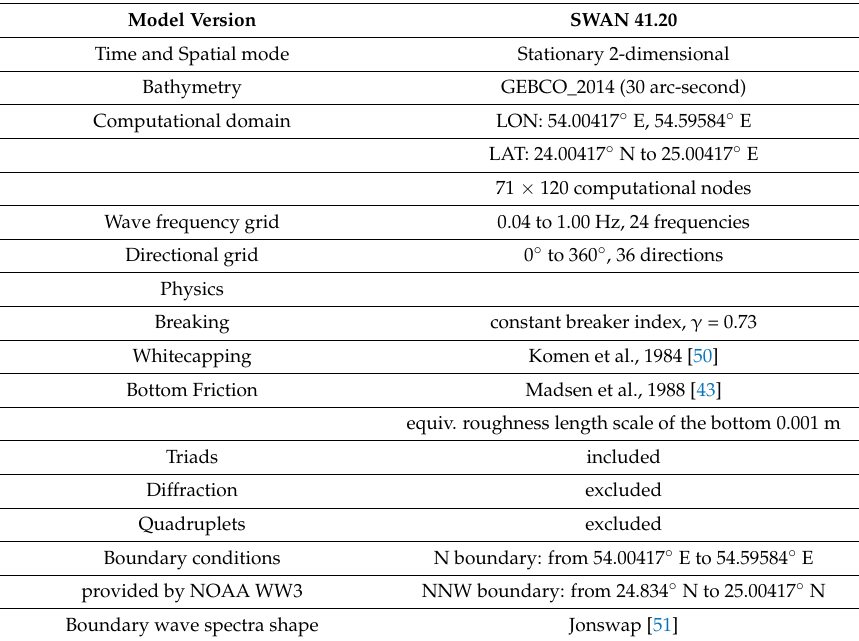
Table 2. Main SWAN configuration